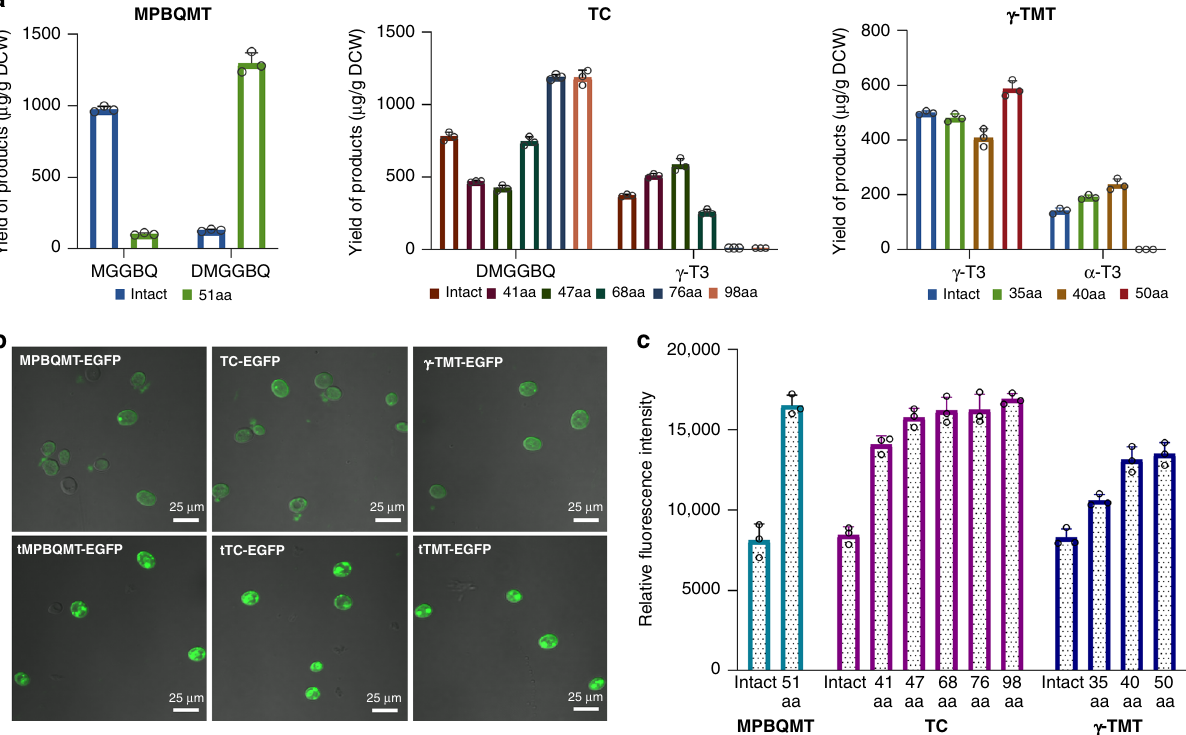
Fig. 3 Prediction and excision of chloroplast transit peptide in MPBQMT, TC, and γ -TMT. a Effect of excising predicted transit peptides with different lengths on the corresponding metabolites of MPBQMT, TC, and γ -TMT. b Laser confocal microscopy of strains expressing fusion proteins of EGFP and MPBQMT, TC, and γ -TMT before and after removal of the transit peptide. Names without pre fi x refer to the full-length proteins, whereas names pre fi xed with ‘ t ’ refer to the truncated ones. The tests were repeated three times independently with similar results. c Changes in relative fl uorescence intensity divided by OD 600 of strains expressing EGFP fused with MPBQMT, TC, and γ -TMT before and after truncation of different length of the N-terminal sequence. All values presented are the means of three biological replicates, and error bars represent standard deviations. Source data are provided as a Source Data fi